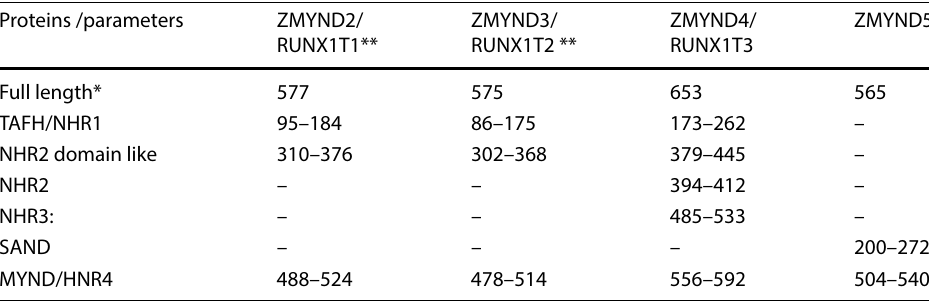
Table 2 Motif composition of Nervy homolog regions containing proteins of ZMYND